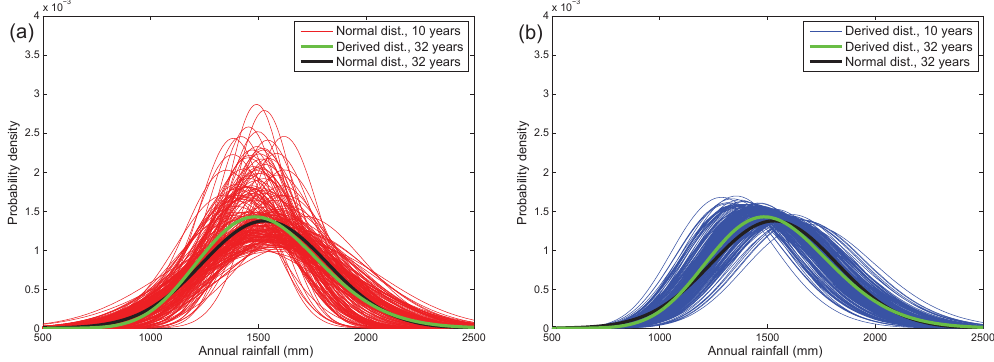
Figure 7. Estimated pdfs for 10-year subsamples using normal distributions (red, a ) and derived distributions (blue, b ) in Lugano.